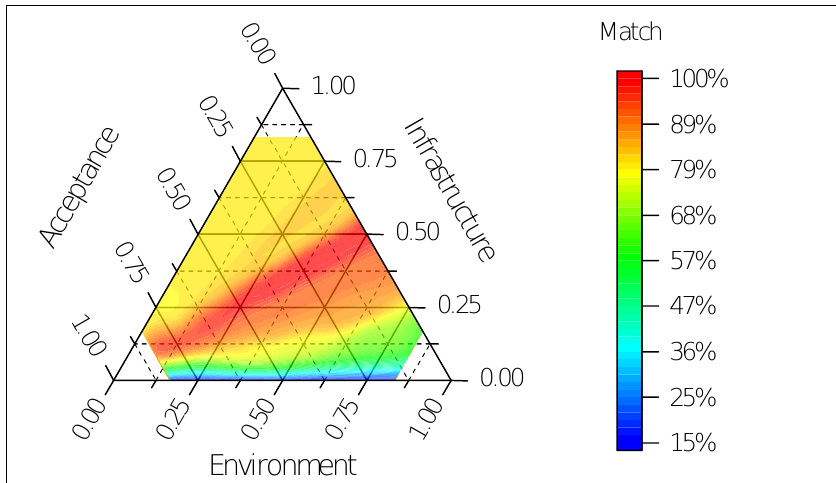
Figure A4. Influence of different weighting factors on similarity compared to the case with equally weighted influencing factors for the DC SWE/FIN project. Own